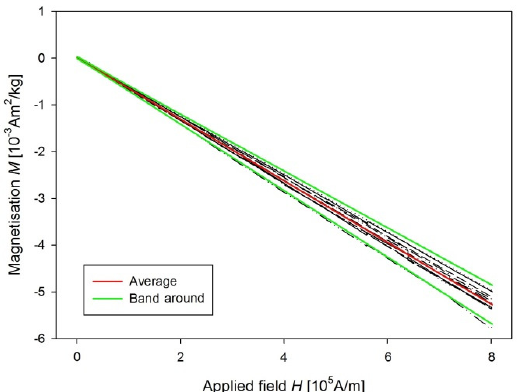
(cid:3036) , where the parameters of